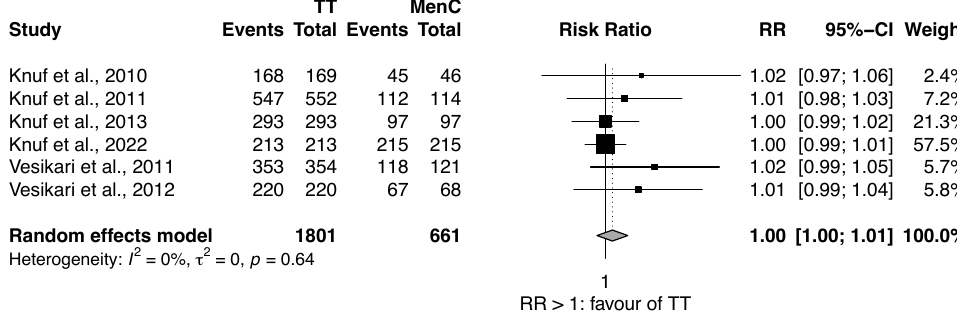
Figure 4. Efficacy of MenACWY-TT vs. MenC (Serogroup C)